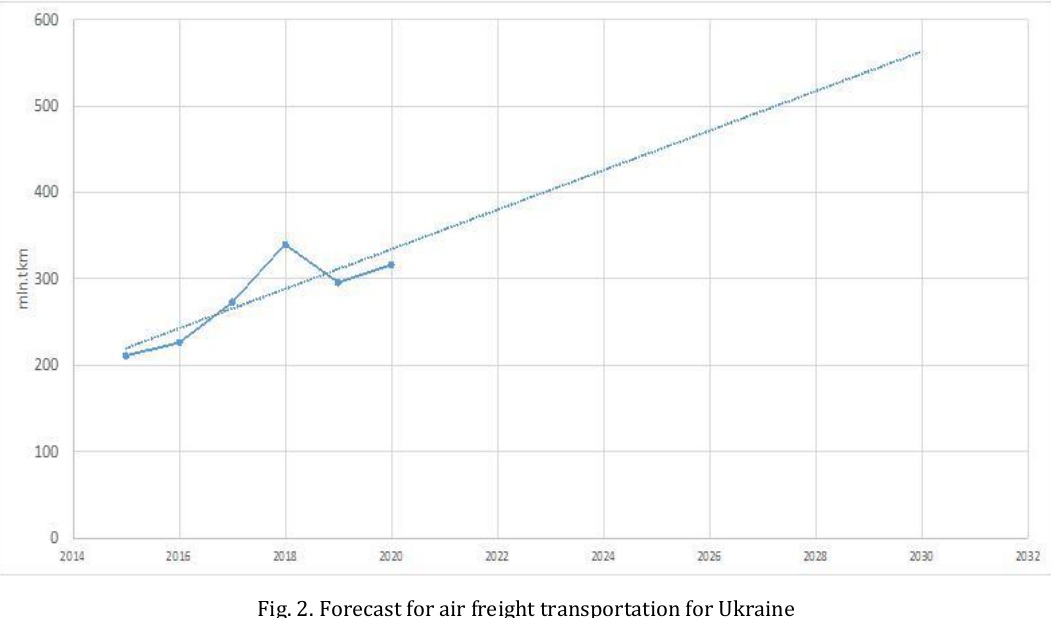
Fig. 2. Forecast for air freight transportation for Ukraine